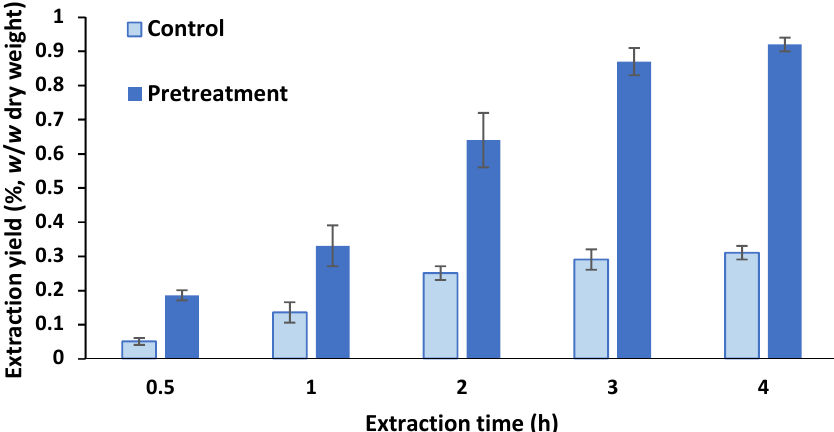
Figure 1. Extraction yield expressed as % ( w / w dry weight). Kinetics of supercritical CO 2 extraction (pressure 300 bar, temperature 40 °C) of Tetradesmus obliquus biomass, described in Section 3.2 in detail.